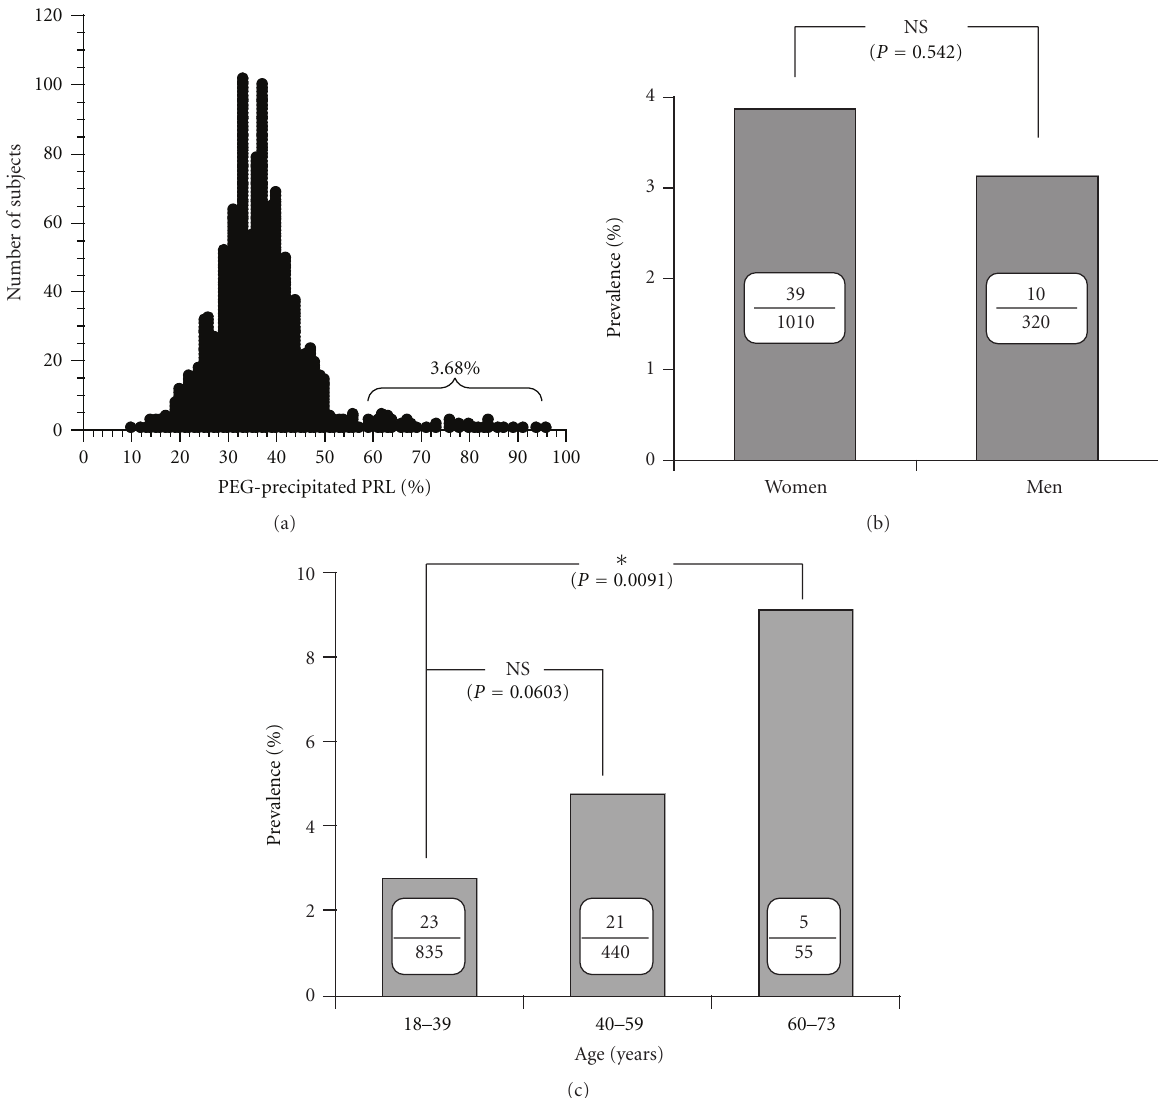
Figure 3: The prevalence of macroprolactinemia and its gender and age dependency in normal subjects. (a) The circle represents the value of PEG-precipitation ratio in each individual and the vertical line shows the number of subjects. The graph shows almost a normal distribution except for a subgroup (macroprolactinemia) having the ratio greater than 60% (mean + 2SD). (b) The prevalence of macroprolactinemia in women and men. (c) The prevalence of macroprolactinemia in di ff erent age groups. (Reproduced from